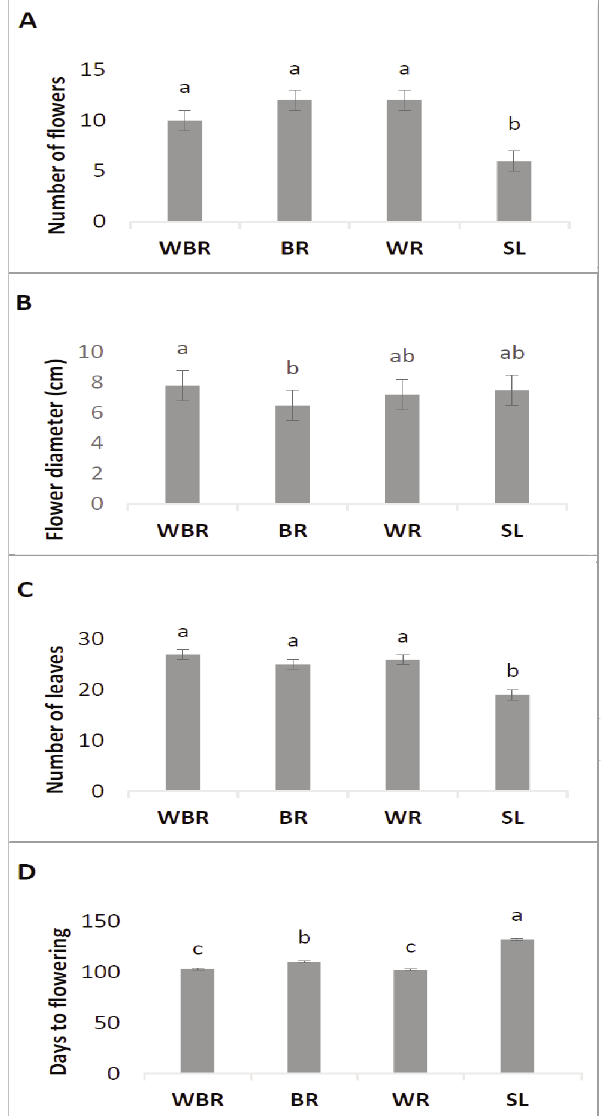
Fig. 2 ­ Morphological characteristics and time to reach flower of transplants grown under white+blue+red (WBR), blue+red (BR), white+red (WR) and sunlight in pot stage. The mean of values ± Standard deviation (n=5) is displayed. Values with the same letter in column do not significantly differ (by the tukey’s test, p≤0.05). The explanations for the treatment abbreviations are provi­ ded in Table